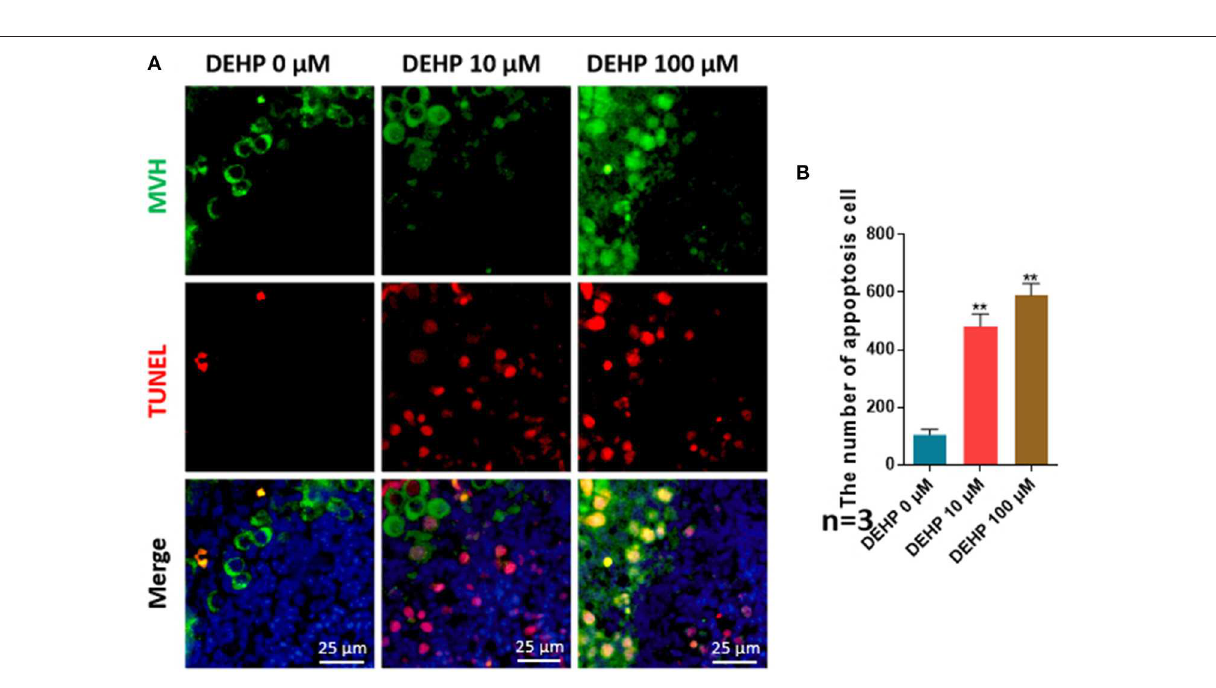
FIGURE 1 | DEHP Exposure affects germ cell cyst breakdown and primordial follicle assembly. (A) Histological sections of 3 dpp mouse ovaries cultured with different concentration of DEHP for 3 days. Oocytes are stained red with anti-Mvh antibody, nuclei are stained blue with Hochest 33342; (B) percent of germ cells in nests and follicles after treated with different concentration of DEHP. The results are presented as mean ± SD of at least three independent experiments. * P < 0.05.